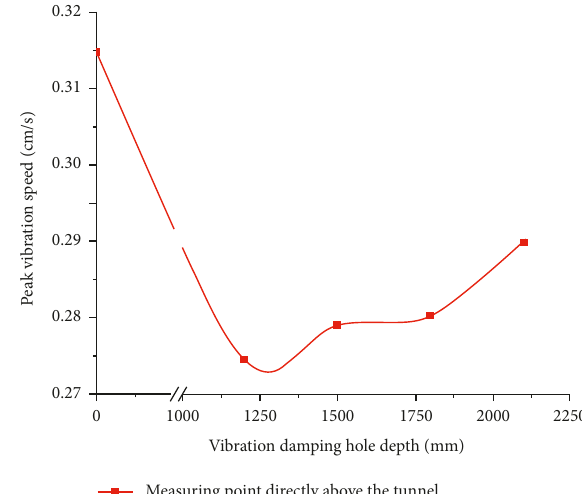
Figure 9: Peak vibration velocity of the damping hole depth.